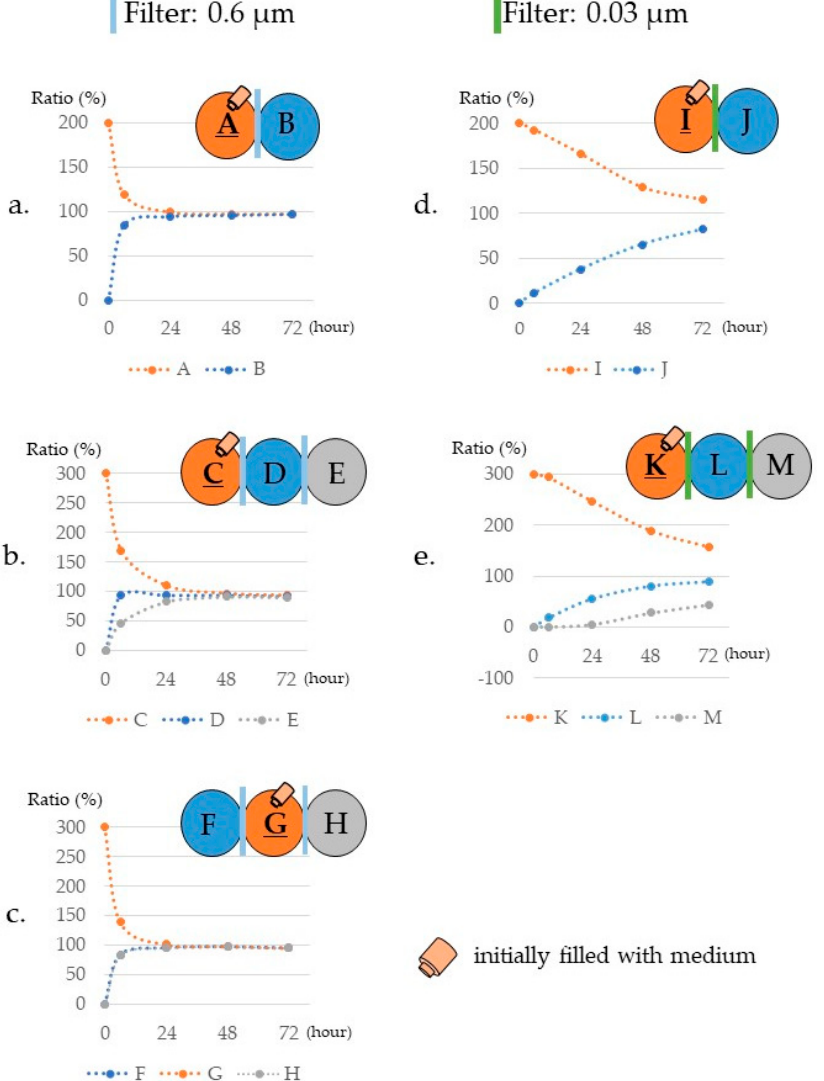
Figure 4. The results of glucose transfer without cells. Orange-colored wells with clip art of bottle were filled with medium including glucose. The remaining wells were filled with phosphate-buffered saline (PBS), which did not contain glucose. When all wells were mixed, the final concentration was converted to 100%. The vertical axis shows the converted concentration in %. Glucose concentration in the medium was measured after 6–72 h. The vertical axis is the concentration (%), and the horizontal axis is the time (h). The filter pore size is 0.6 µ m ( a – c ) or 0.03 µ m ( d , e ). ( a ) In case of 2 linkages and medium on the left side. ( b ) In case of 3 linkages and medium on the left side. ( c ) In case of three connections and a medium in the middle. ( d ) In case of 2 linkages and medium on the left side. ( e ) In case of 3 linkages and medium on the left